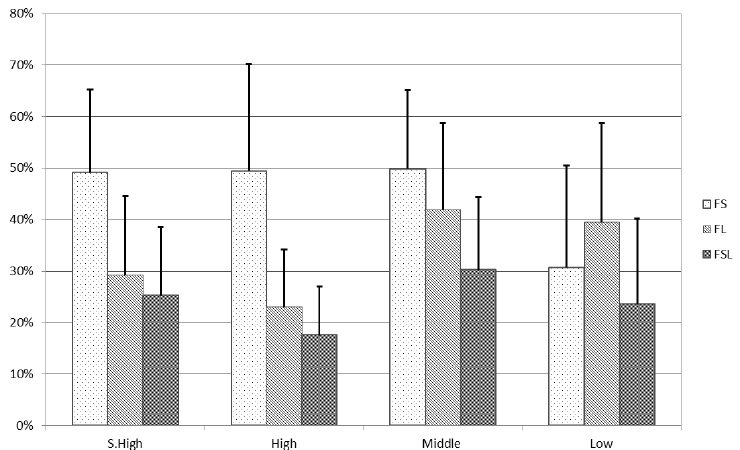
Figure 4. Histogram of the influence of the exclusion criteria on the h-values with sub-cohorts based on the number of